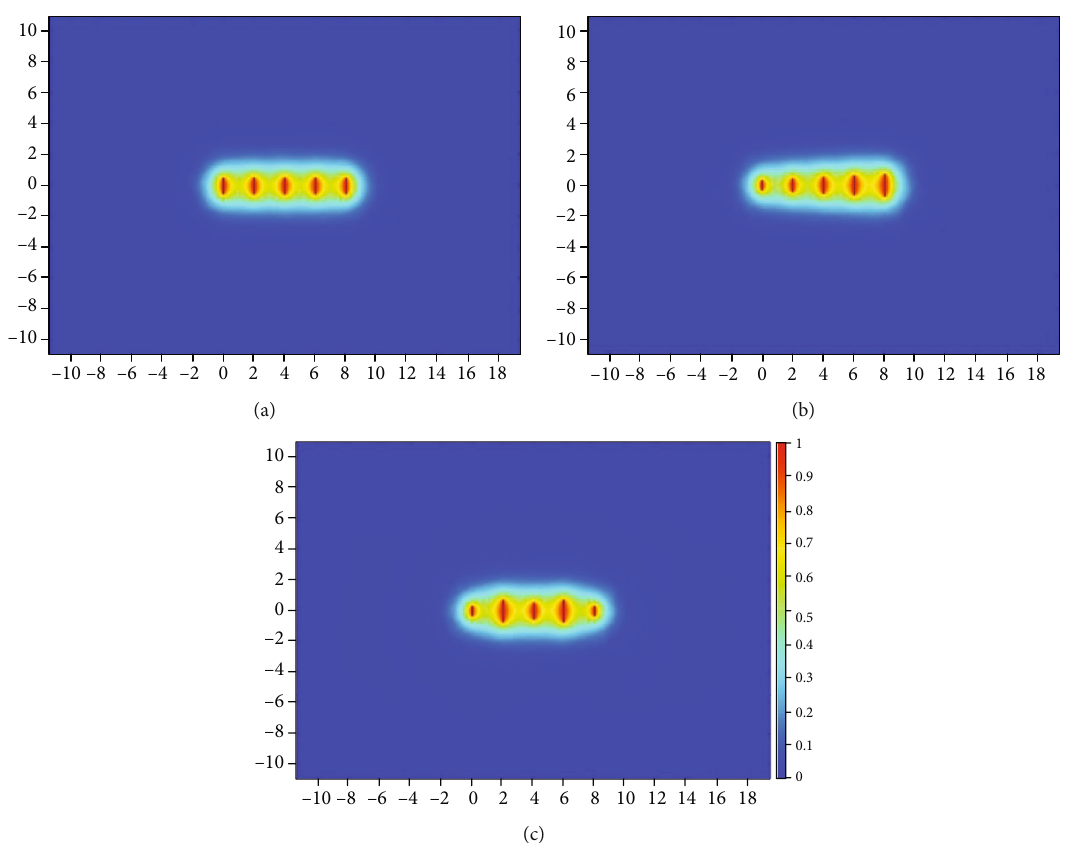
Figure 6: Pressure distribution at di ff erent fracture lengths when the total fracture length is constant: (a) case 1; (b) case 2; (c) case 3. 0.0010.010.110100